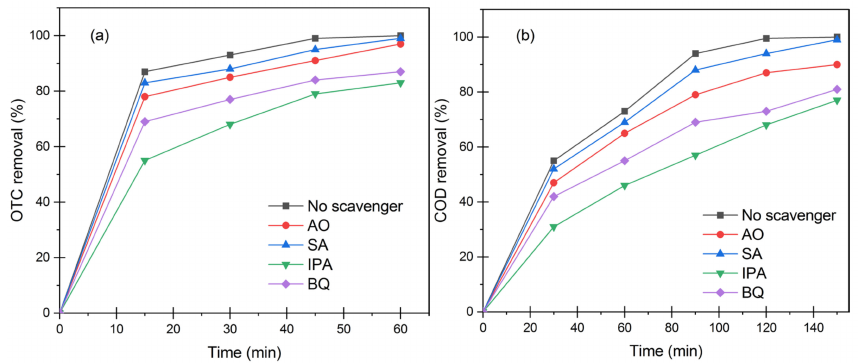
Figure 10. Photodegradation of ( a ) OTC and ( b ) COD with L-Histidine (2 wt.%)-TiO 2 in presence of different scavengers.